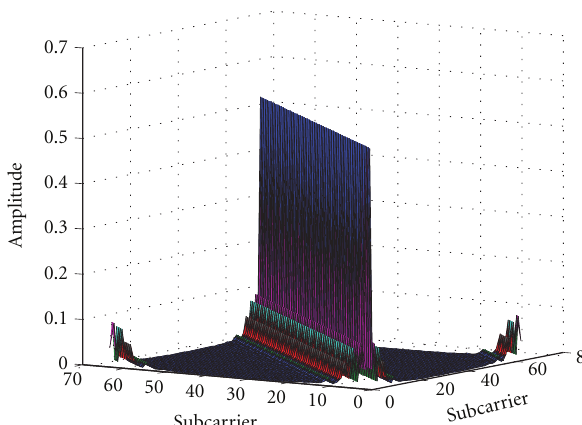
Figure 3: The characteristics of time domain channel matrix H